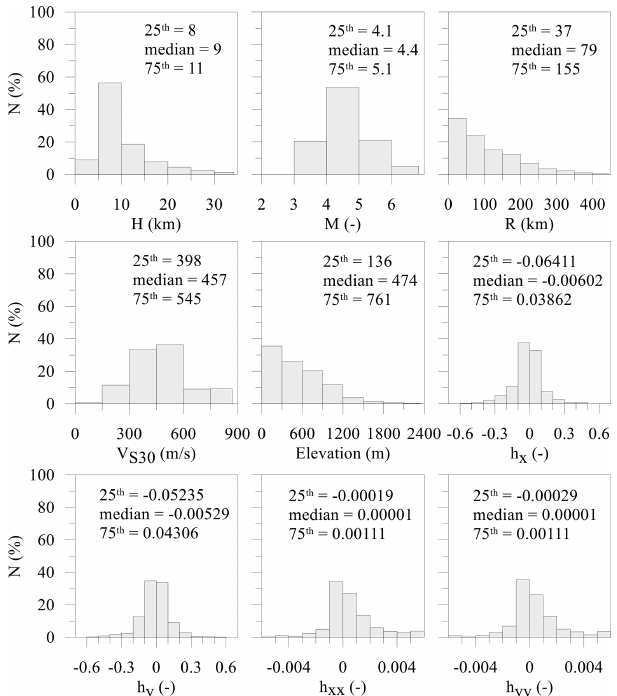
Figure 2. Distribution of input data for the training dataset. N (%): counts (as a percentage).